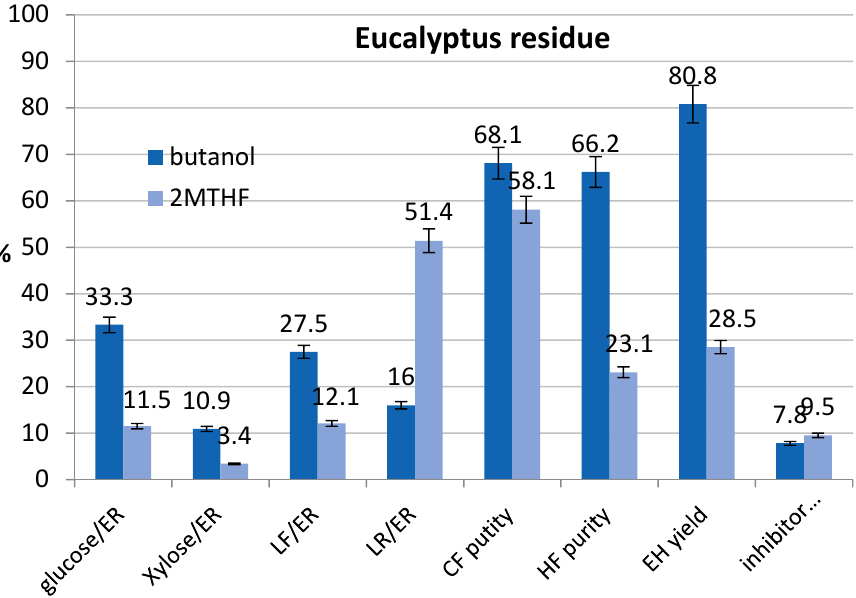
Figure 9. Fractionation and hydrolysis of ER by pretreatment with butanol or 2MTHF.